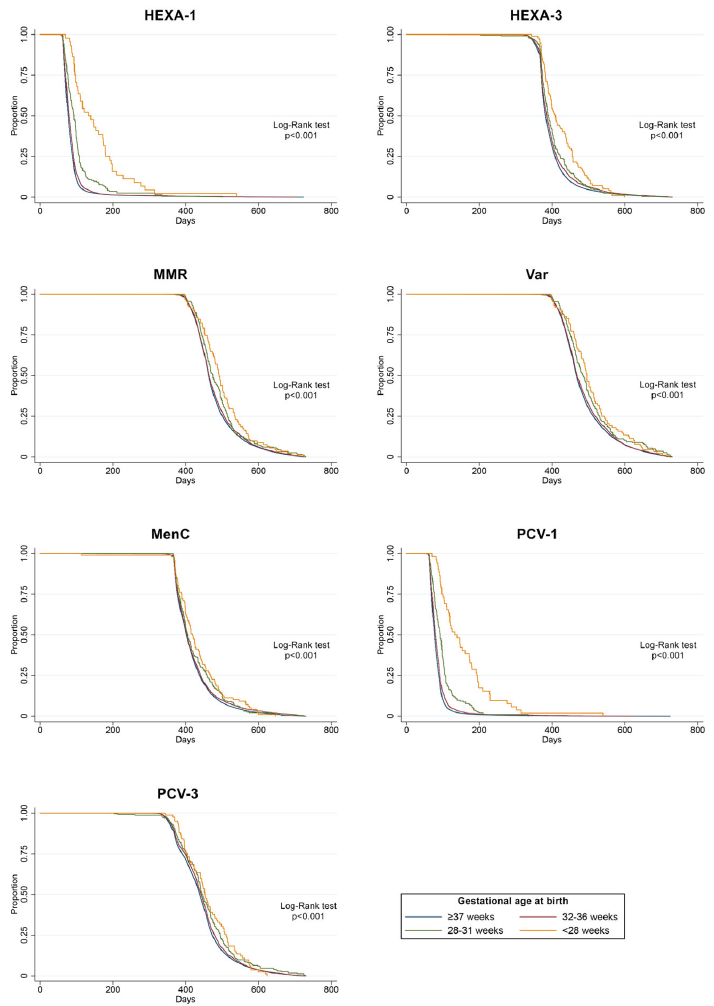
Figure 2. Kaplan–Meier curves for time to start of immunization by gestational age at birth (<28 weeks, 28–31 weeks, 32–36 weeks, ≥ 37 weeks) for HEXA ‐ 1, HEXA ‐ 3, MMR, Var, MenC, PCV ‐ 1, and PCV ‐ 3 vaccine doses.